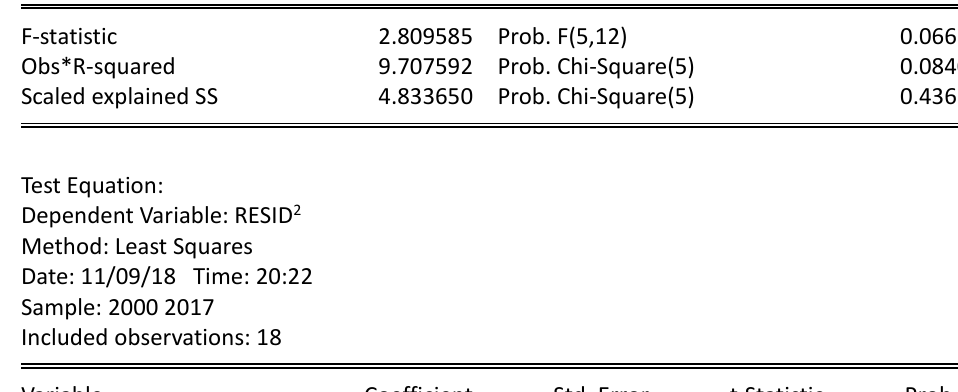
Table 9 Heteroskedasticity Test: White